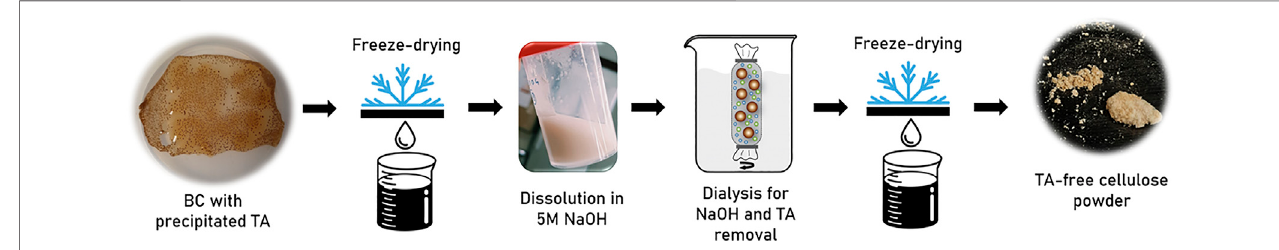
FIGURE1| SchematicrepresentationofthestrategyfortheeliminationofprecipitatedTAfromBCpelliclesproducedintheHSmediumsupplementedwithEGand TA